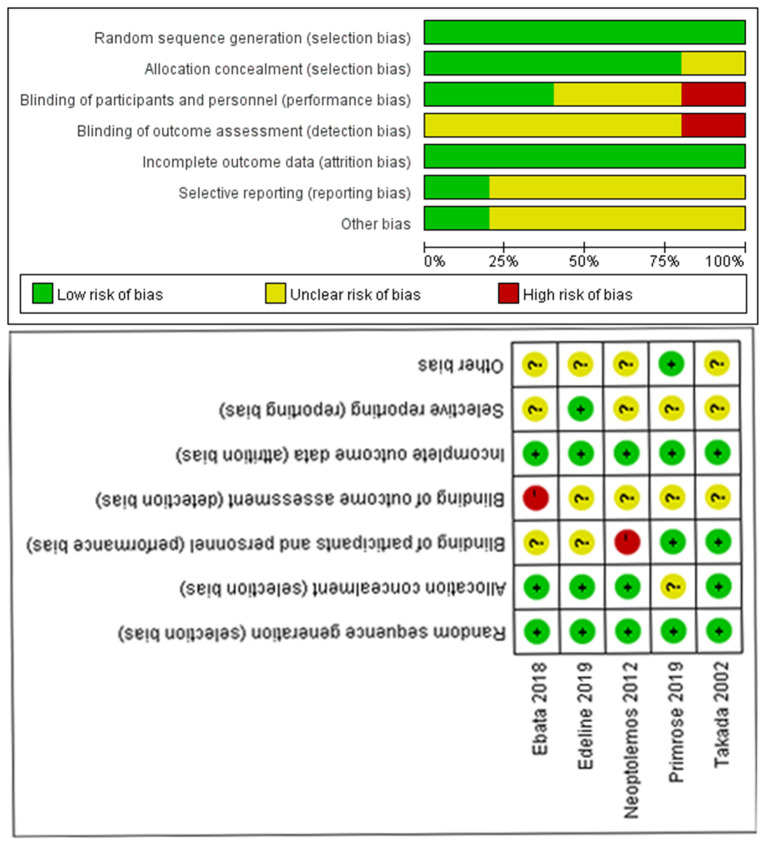
Quality assessment chart.